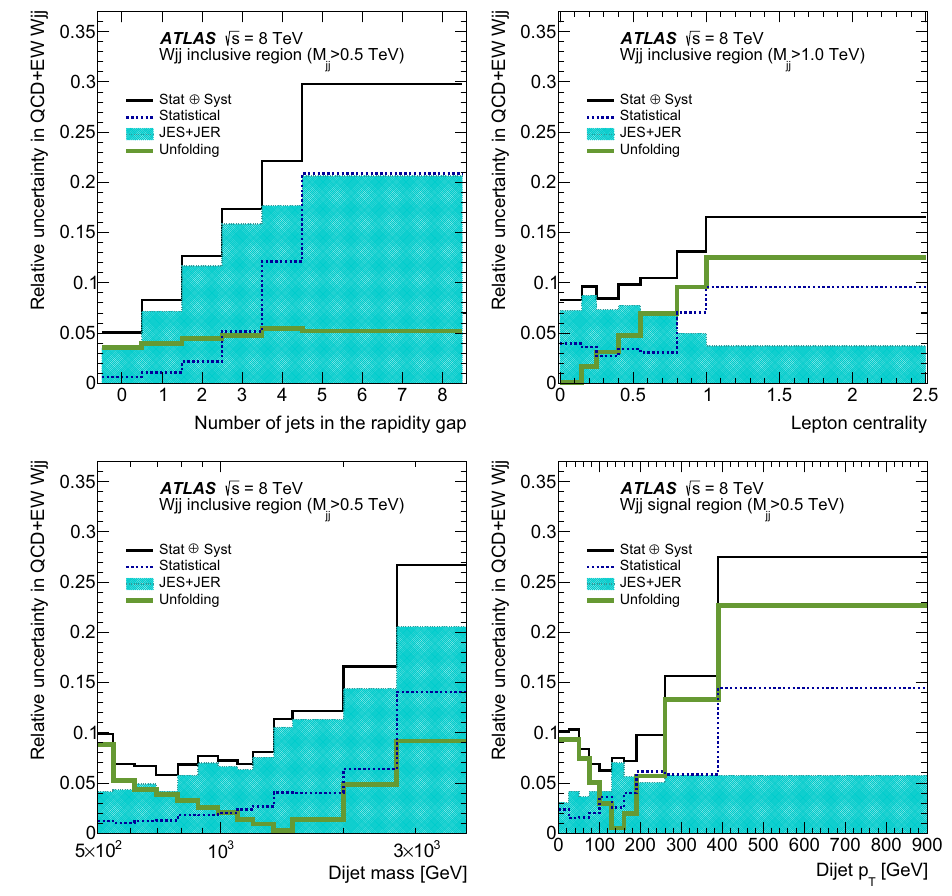
Fig. 11 Relative uncertainties in example unfolded differential cross sectionsforthecombinedQCD+EW W jj processes.Theexamplesare: the number of jets in the rapidity gap between the two highest- p T jets in the inclusive region ( top left ); the lepton centrality distribution in the